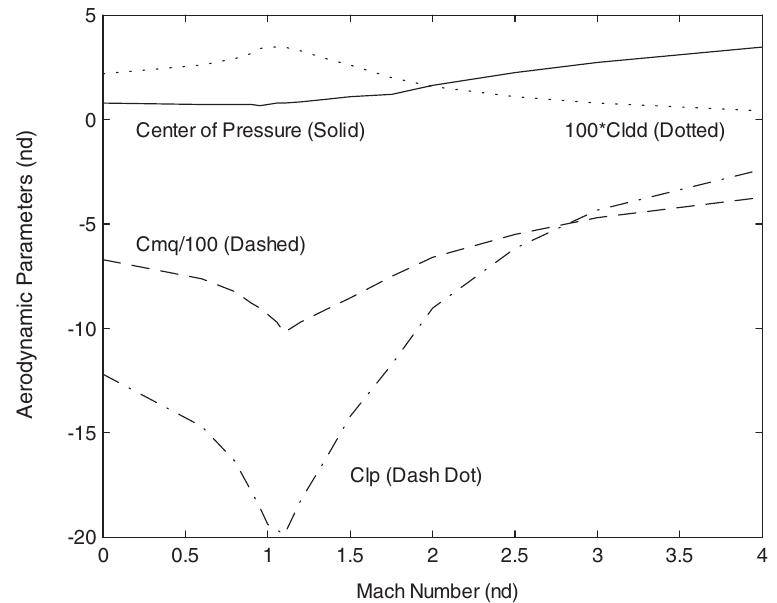
Fig. 3. Body aerodynamic parameters.